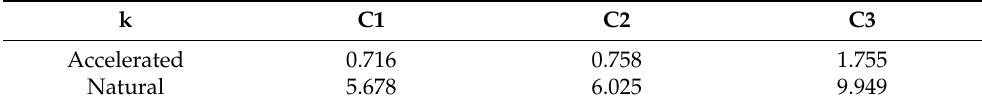
Table 16. k coefficients of C25/30 strength class concretes.